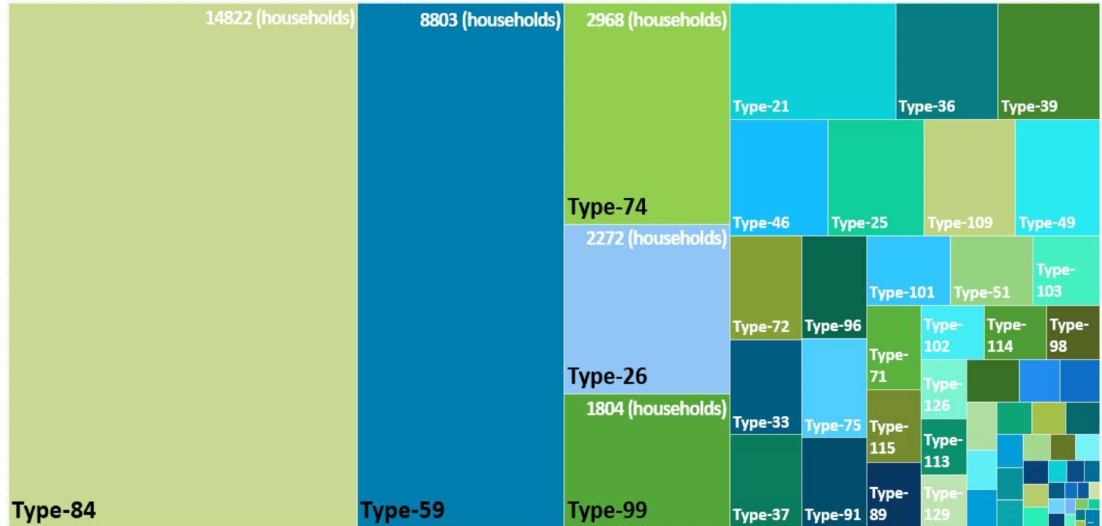
Figure 4. Type distribution of 46,398 households in 46 complexes.